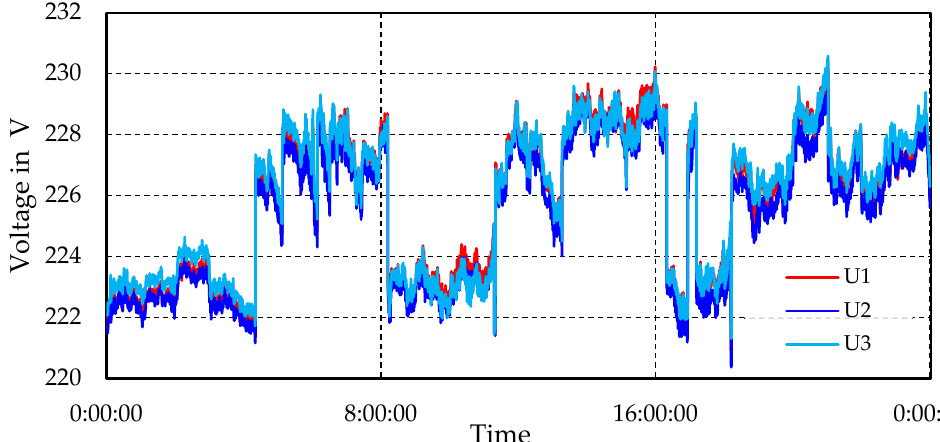
Figure 4. Flow chart of the algorithm used for this study.